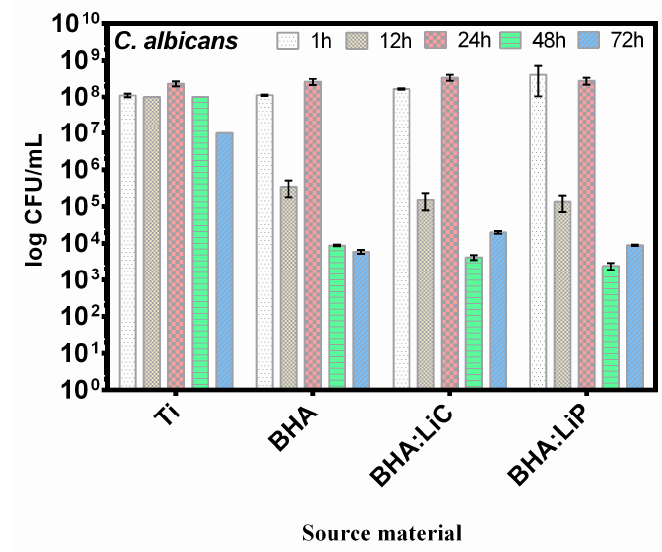
Figure 11. Graphic representation of the logarithmic values of C. albicans biofilm cells developed on the surfaces of Ti, bovine hydroxyapatite (BHA), and doped BHA coatings, at different time intervals (1–72 h) [11]. Slight modifications of the acronyms from the original figure were done for uniformization with the sample codes used in this review.